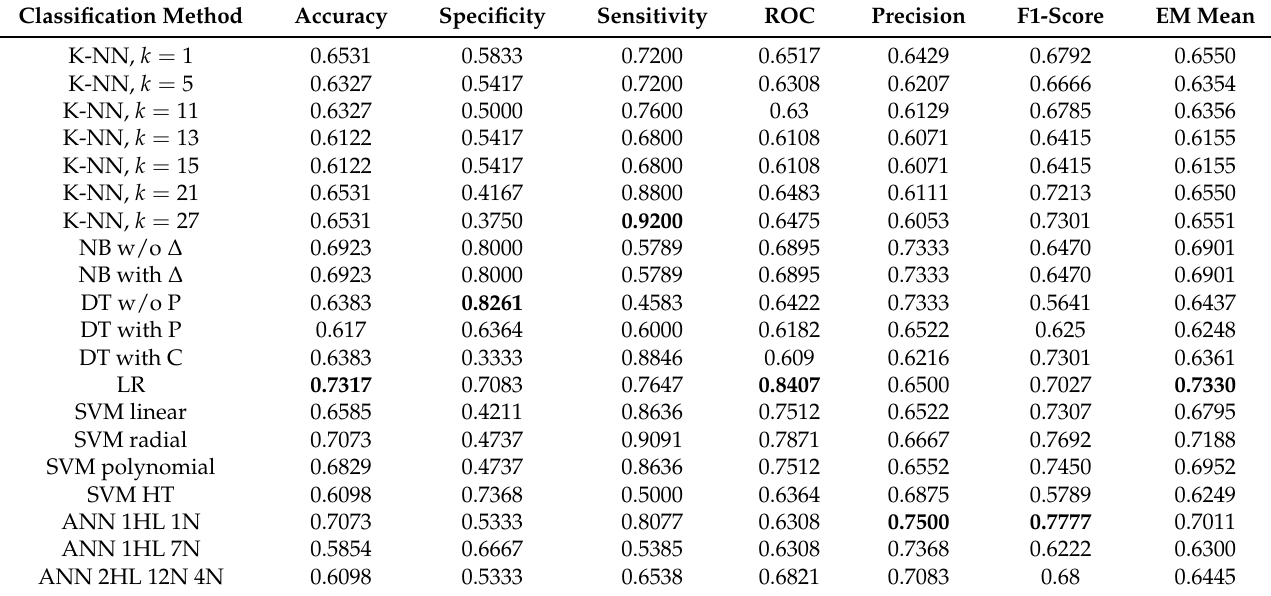
Table 2. Evaluation metrics for each classifier of the normalized dataset.